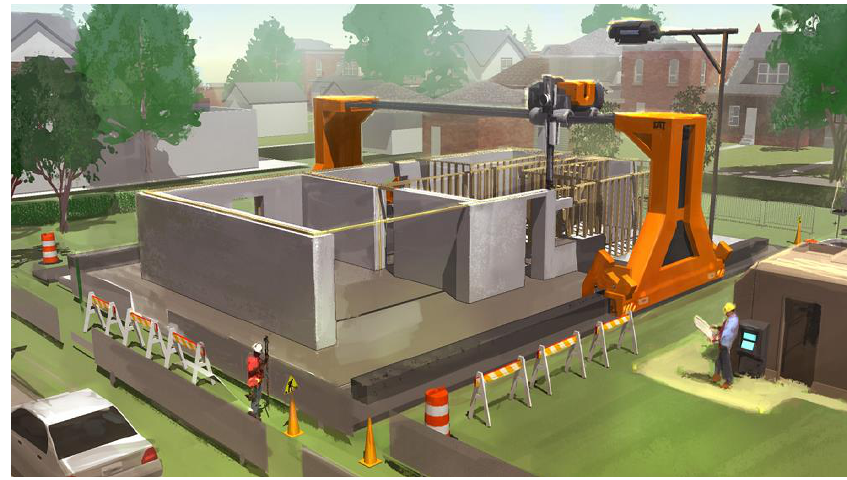
Figure 1. Outline of a working contour crafting machine [4].